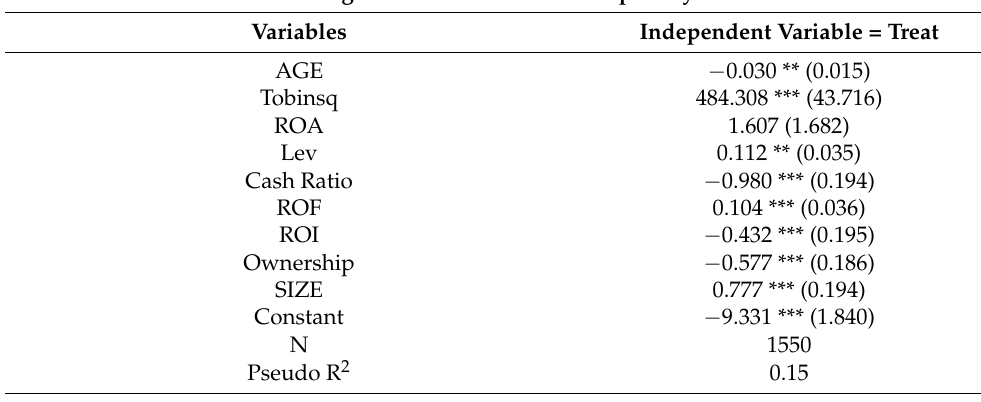
Table 3. Propensity score matching procedure. Panel A: Logit Model Used to Find Propensity Scores